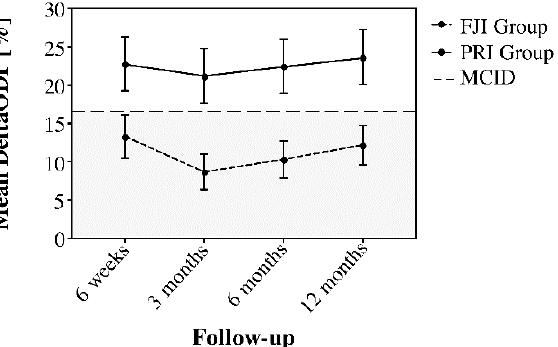
Figure 4. Comparison of deltaODI between the FJI and PRI groups over the follow-up period to illustrate the duration of the treatment effect concerning the minimal clinically important difference (MCID, horizontal line at a deltaODI of 16%). The FJI group was below the horizontal line in the